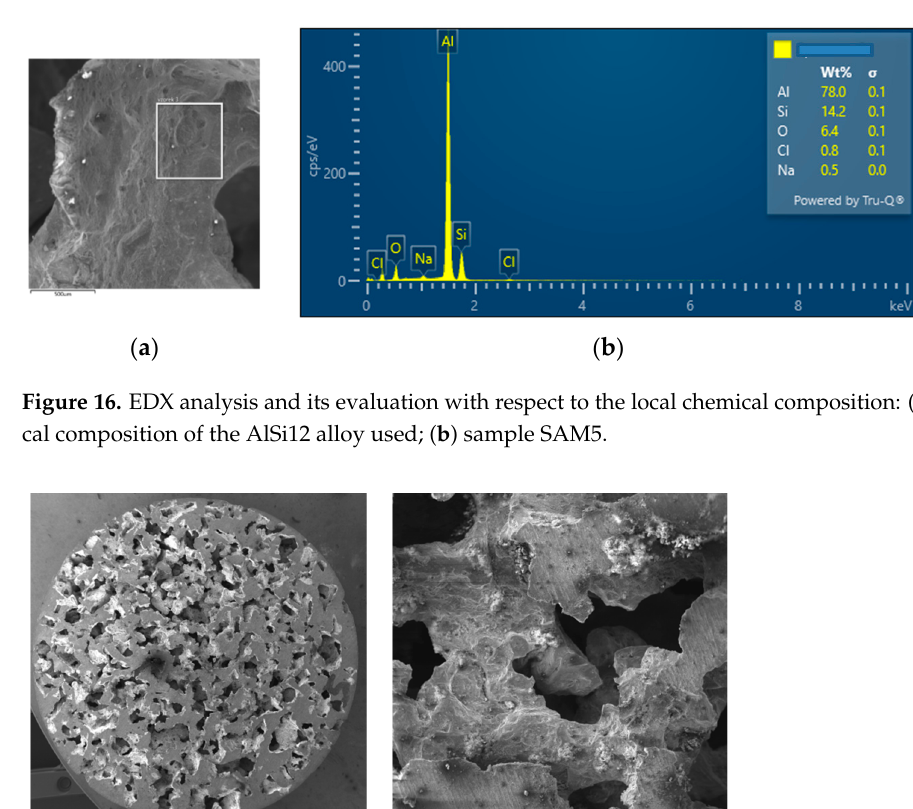
Figure 15. View of the structure of the porous material of AlSi12 alloy: ( a ) detail of the material; ( b ) scanning electron microscope image (Vega 3 Tescan, SEM HV 20.0 kV) of sample SAM5.